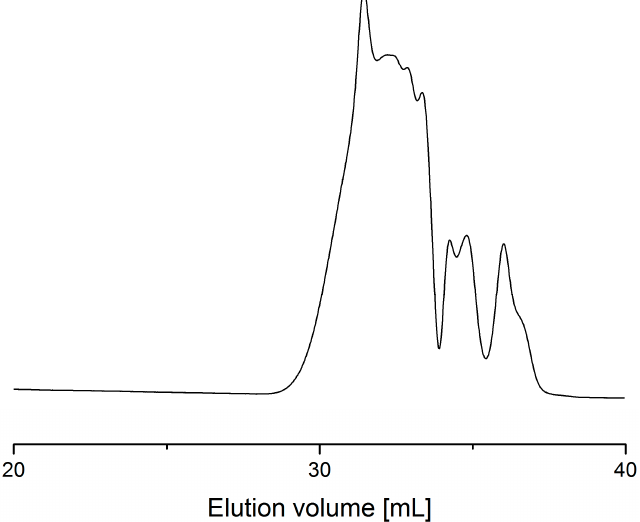
Figure 1. Gel permeation chromatography (GPC) eluogram of glycerol oligomers obtained using SAIREM MW open reactor with K 2 CO 3 (4 wt %) as catalyst, 237 °C, 16 h.